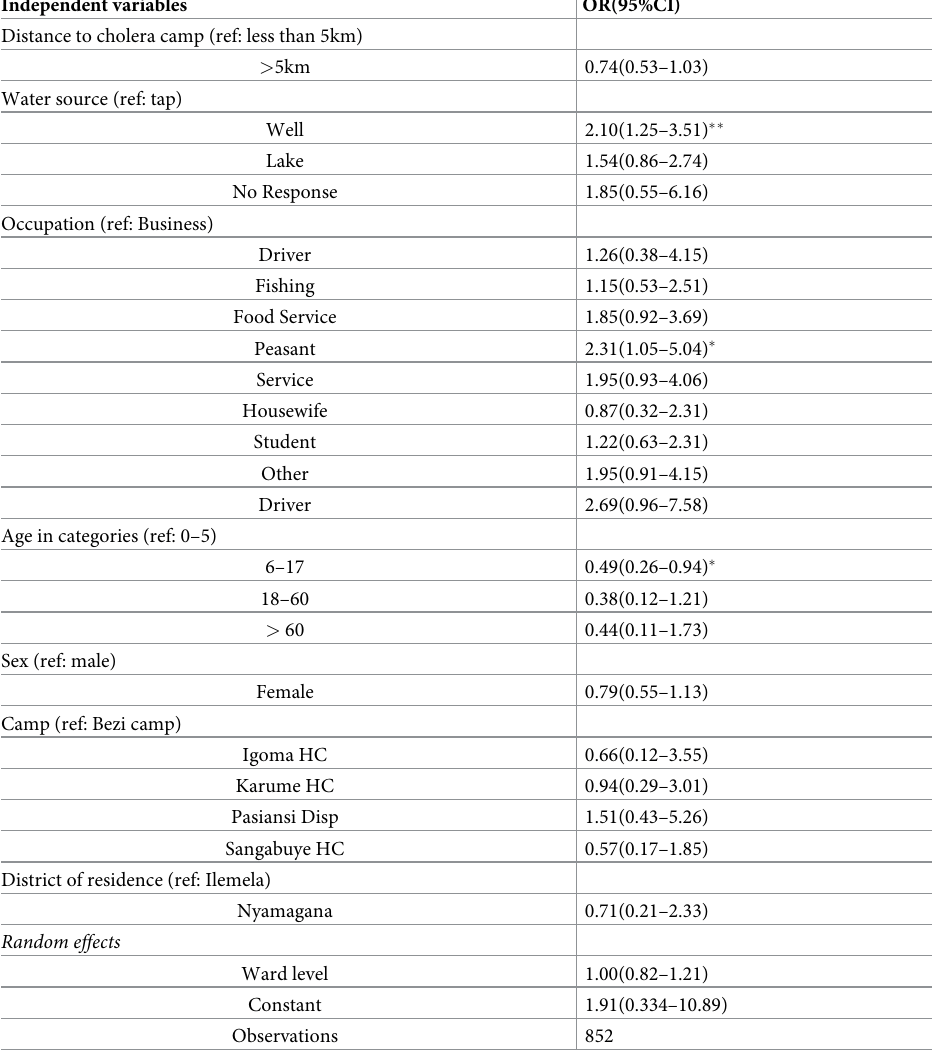
Table 4. Determinants of time of seeking health care during a cholera